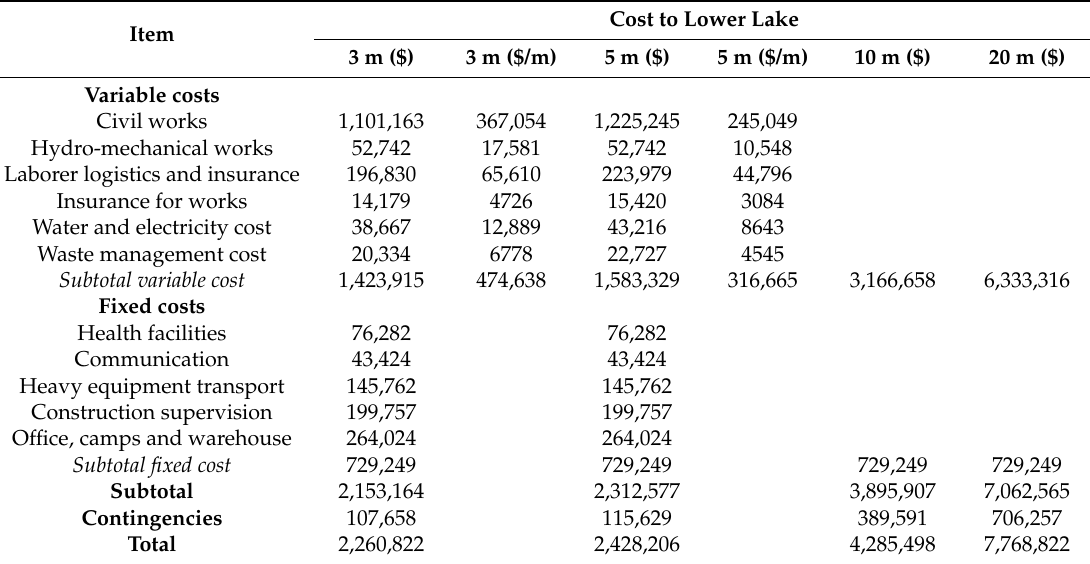
Table 2. Cost estimates for Imja Lake lowering works. Adapted from CEPAD